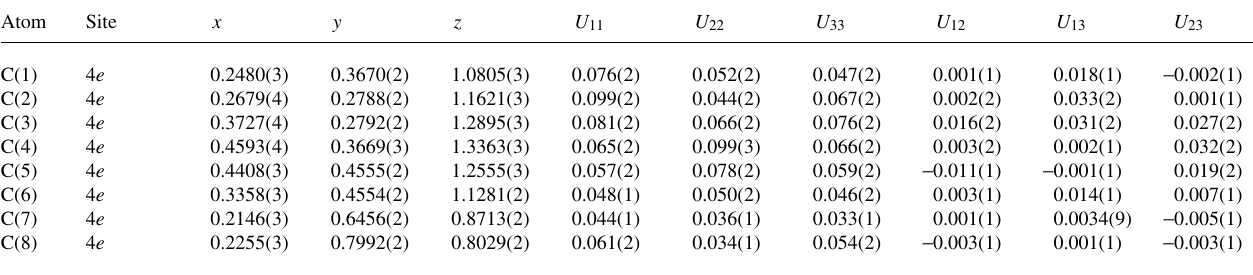
Table 3. Atomic coordinates and displacement parameters (in Å 2 )